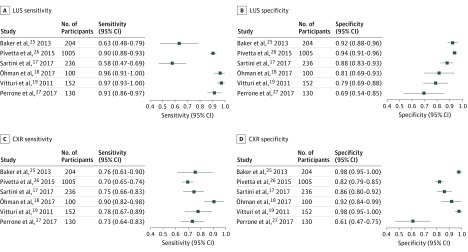
Forest Plots for Lung Ultrasonography and Chest RadiographyCXR indicates chest radiography; LUS, lung ultrasonography.